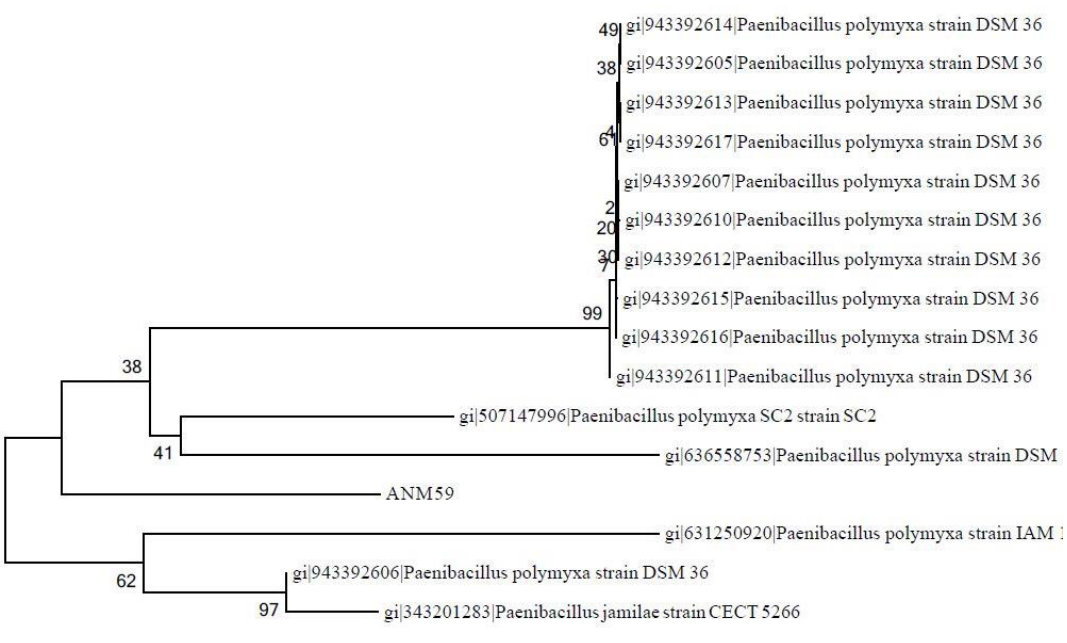
Figure 4. Neighbour-joining phylogenetic tree produced using multiple alignment of 16S rRNA gene sequence of Paenibacillus polymyxa ANM59 with those of other bacterial strains found in the GeneBank database.